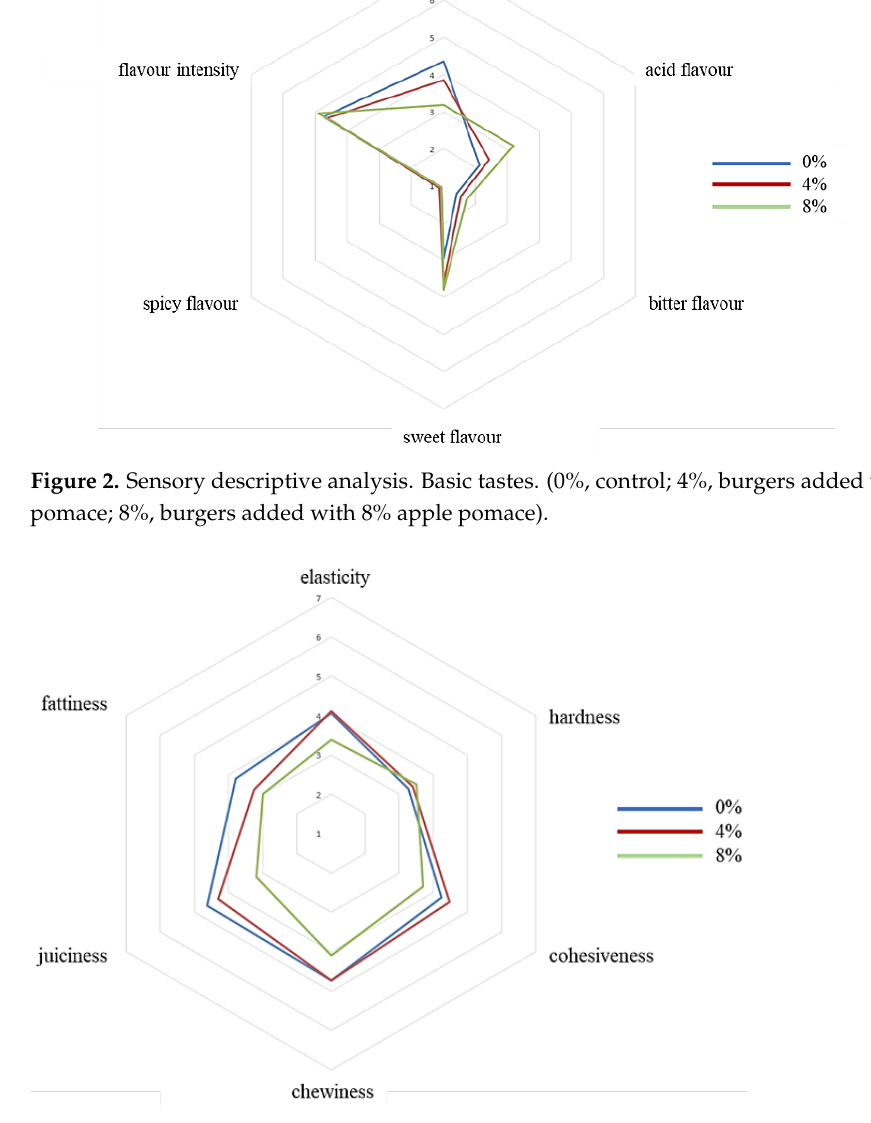
Figure 3. Sensory descriptive analysis. Texture attributes. (0%, control; 4%, burgers added with 4% apple pomace; 8%, burgers added with 8% apple pomace).